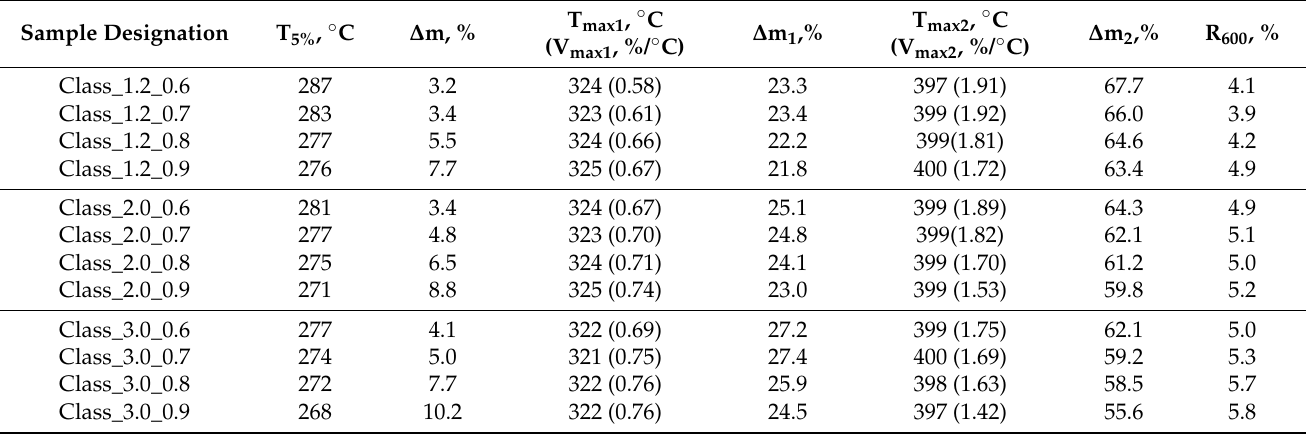
Table 6. Foam parameters determined from thermogravimetric (TG) and derivative thermogravimetric (DTG) curves.